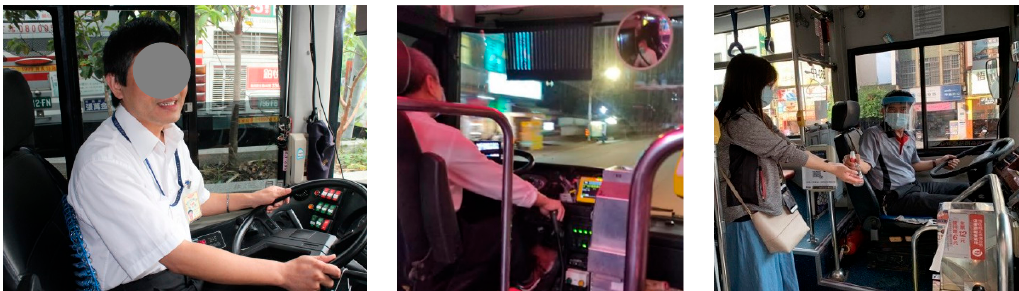
Figure 1. Bus drivers while working .